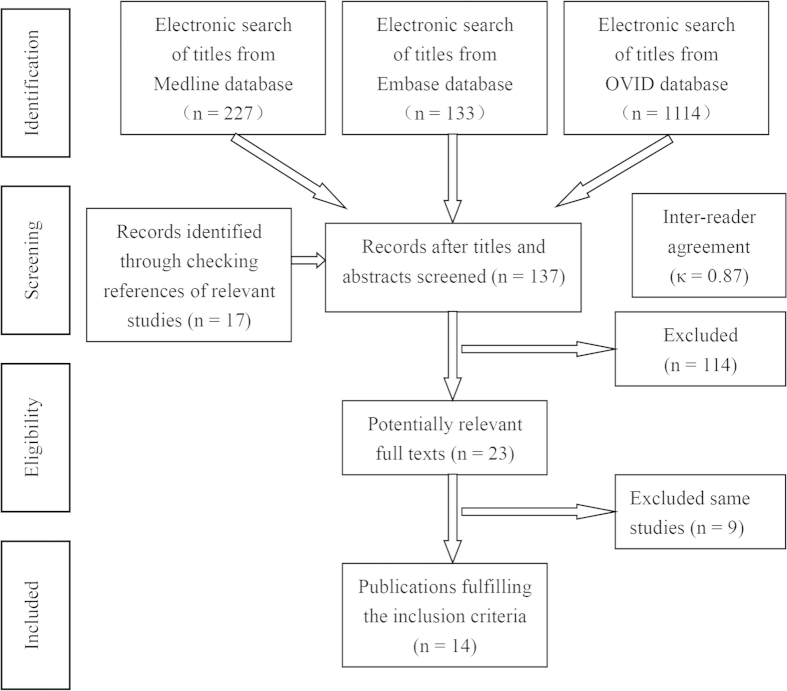
Flow-chart depicting the literature search procedure.